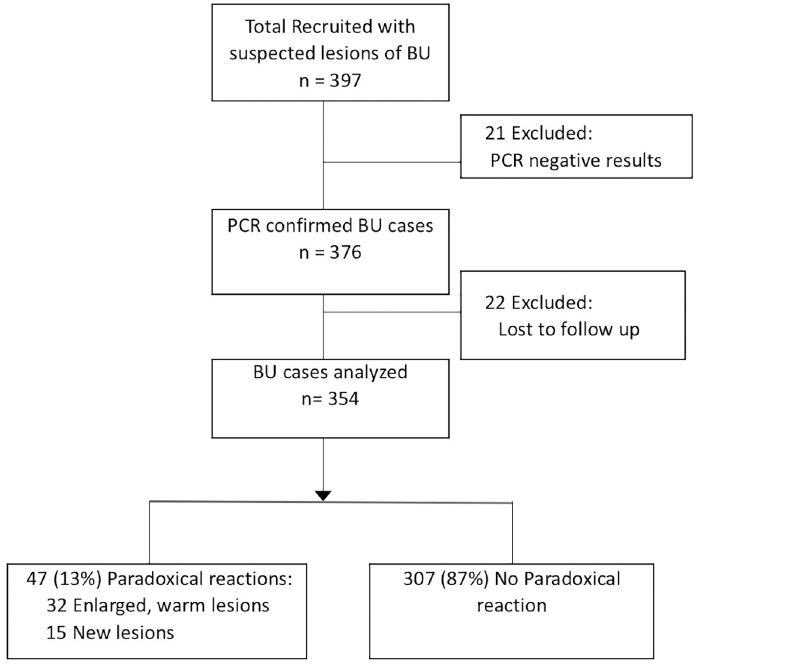
Fig 1. Flowchart of study participants,